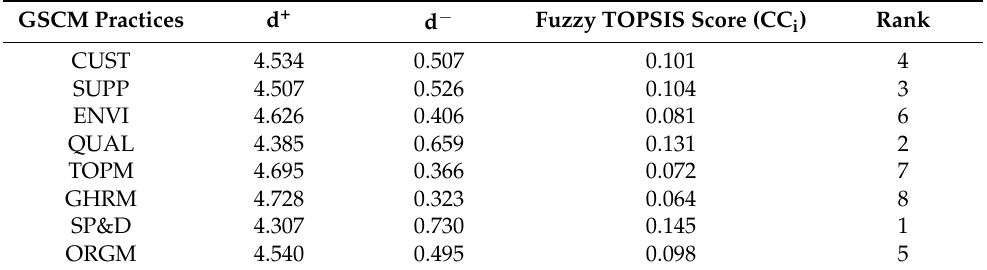
Table 5. Fuzzy technique for order preference by similarity to ideal solution results.